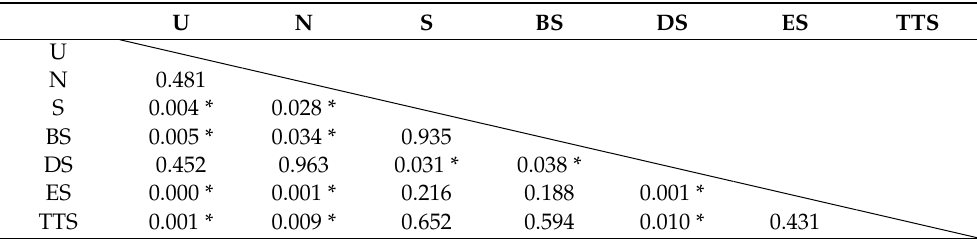
Table 4. Significance of ANCOVA pairwise comparison for the embedment-strength test (groups U, N, S, BS, DS, ES and TTS) [31]. U N S BS DS ES